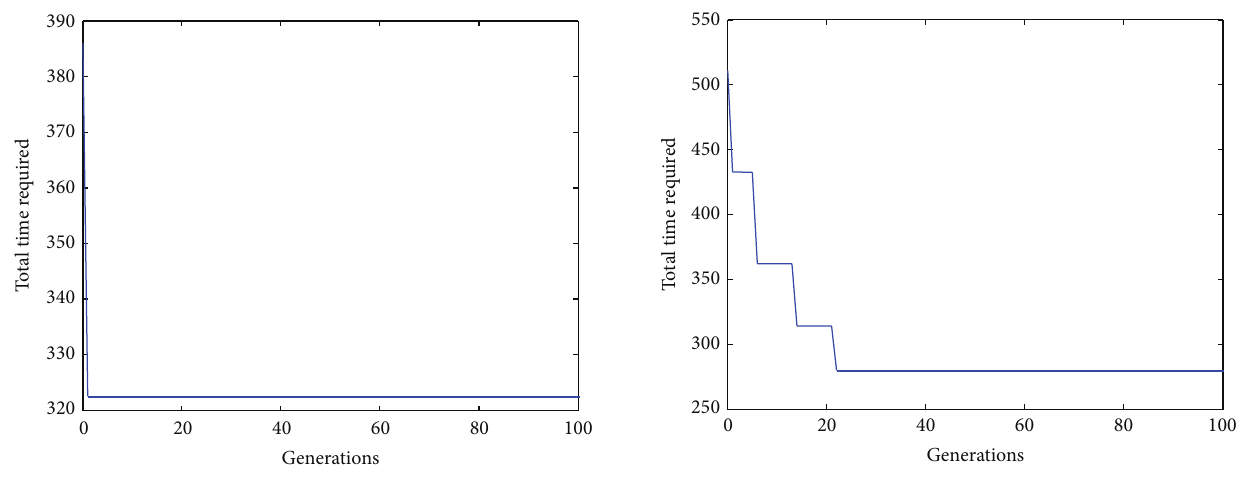
Figure 4: The convergence curve for workpiece 1. Figure 5: The convergence curve for workpiece